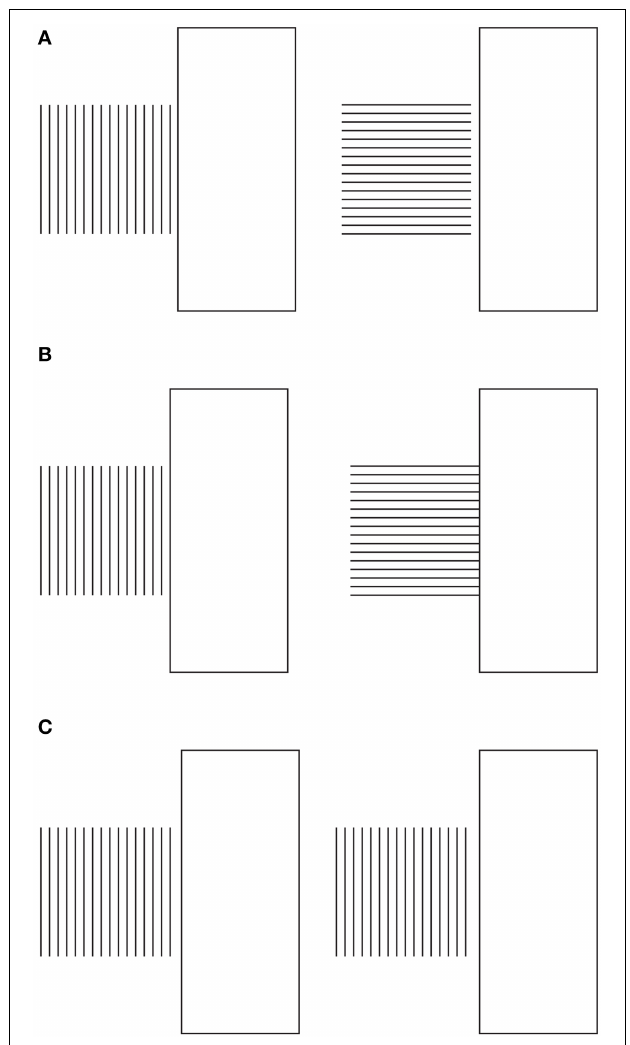
FIGURE 11 | The strength of the global directional organization can be perceived by comparing the strength of the amodal continuation of the vertical and horizontal arrangement of lines when a rectangle is placed nearby (for details see the text). For further details please see the